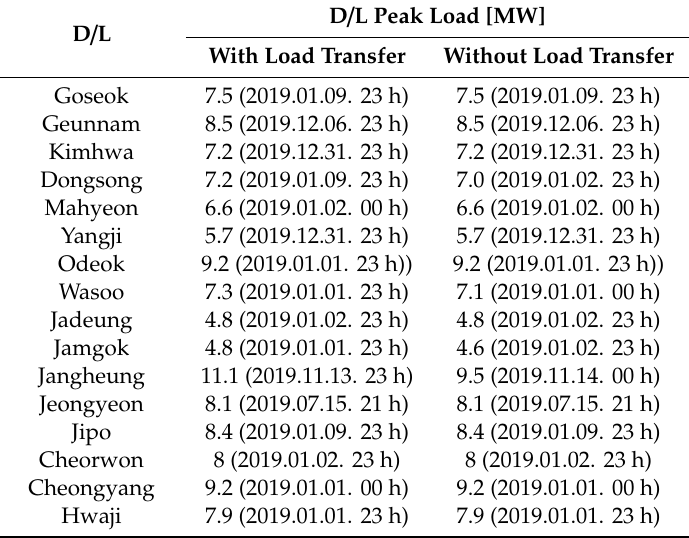
Table 2. Peak load change due to load transfer